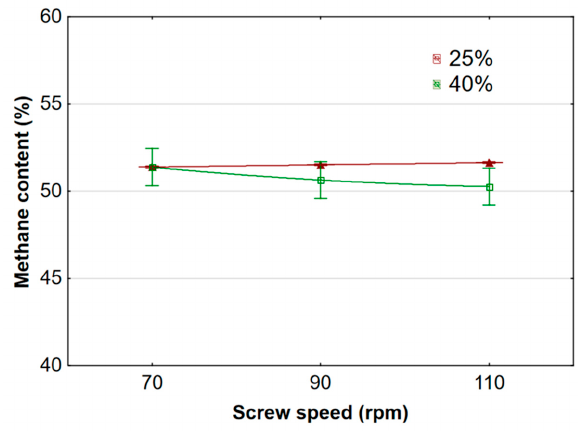
Figure 3. Methane content in produced biogas after fermentation of corn straw pretreated in various extrusion-cooking conditions.